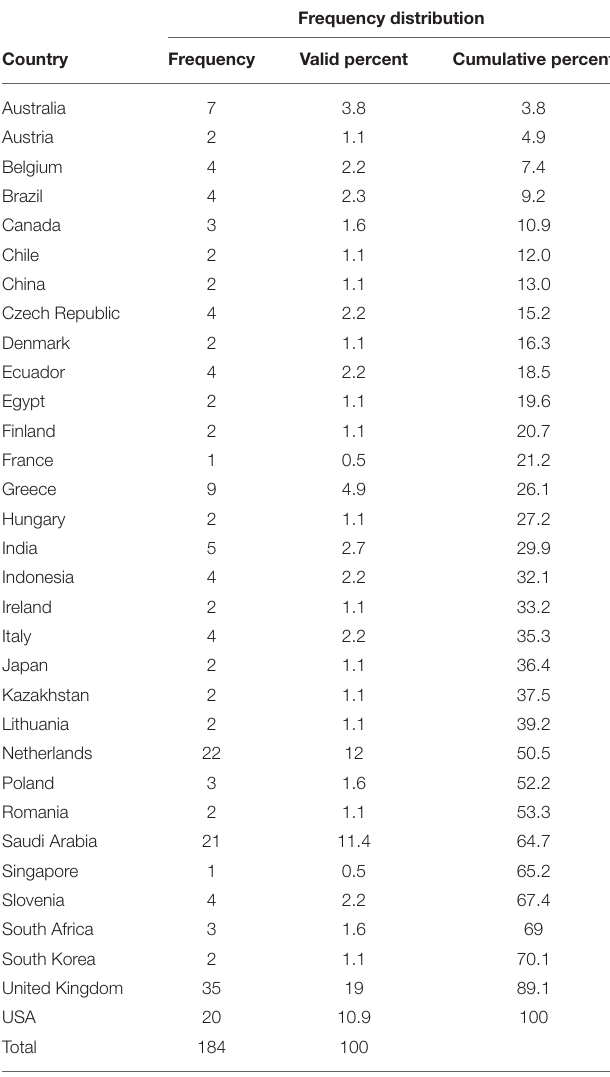
TABLE 6 | Frequency distribution of sample by country. Frequency distribution